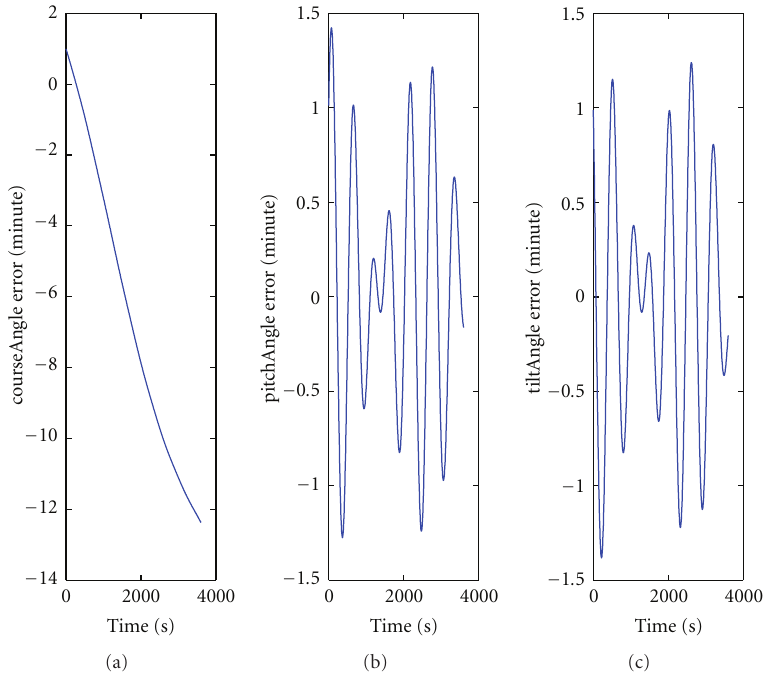
Figure 16: Angle error of circle